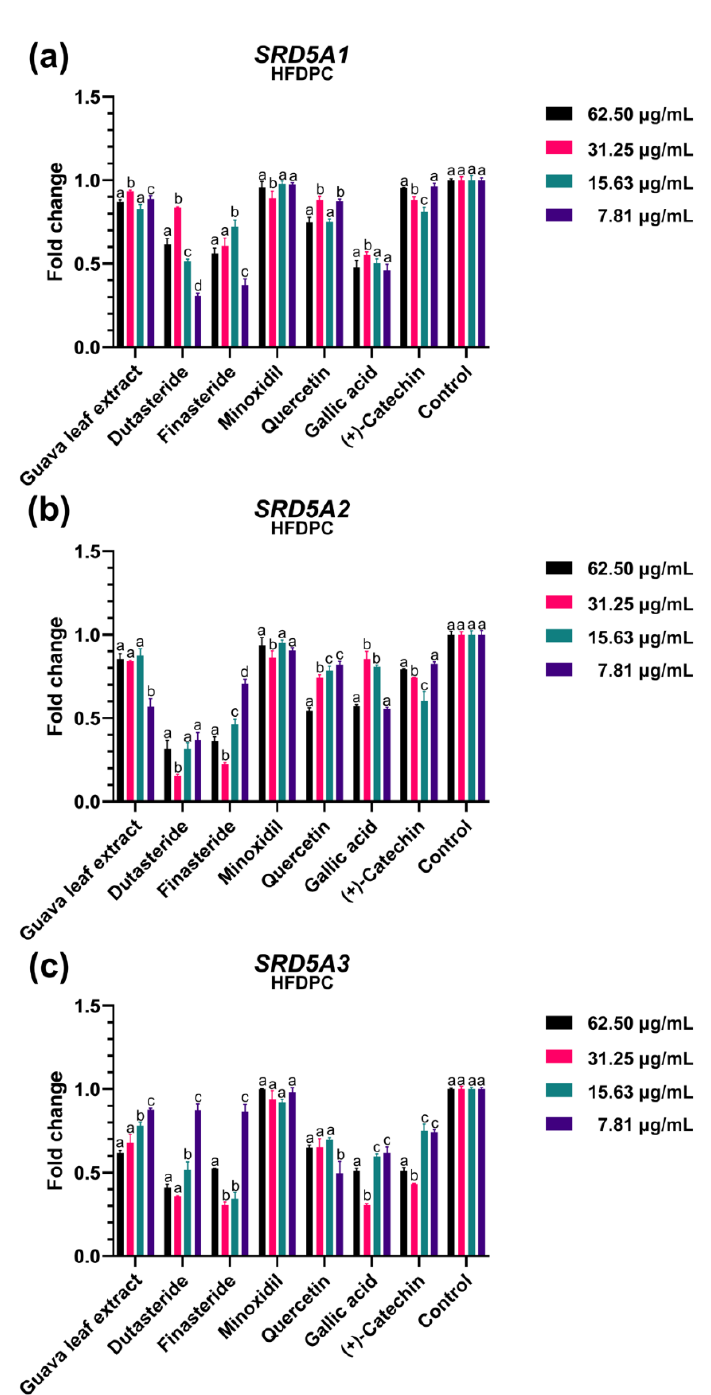
Figure 2. The effects of the guava leaf extract and standard reference compounds (dutasteride, finasteride, minoxidil, quercetin, gallic acid, and (+)-catechin) at different concentrations (62.50, 31.25, 15.63, and 7.81 μg/mL) on the expression of ( a ) SRD5A1 , ( b ) SRD5A2 , and ( c ) SRD5A3 in human hair follicle dermal papilla cells (HFDPC). Values not sharing the same superscript letter are significantly different ( p < 0.05) when compared between concentrations of each treatment.